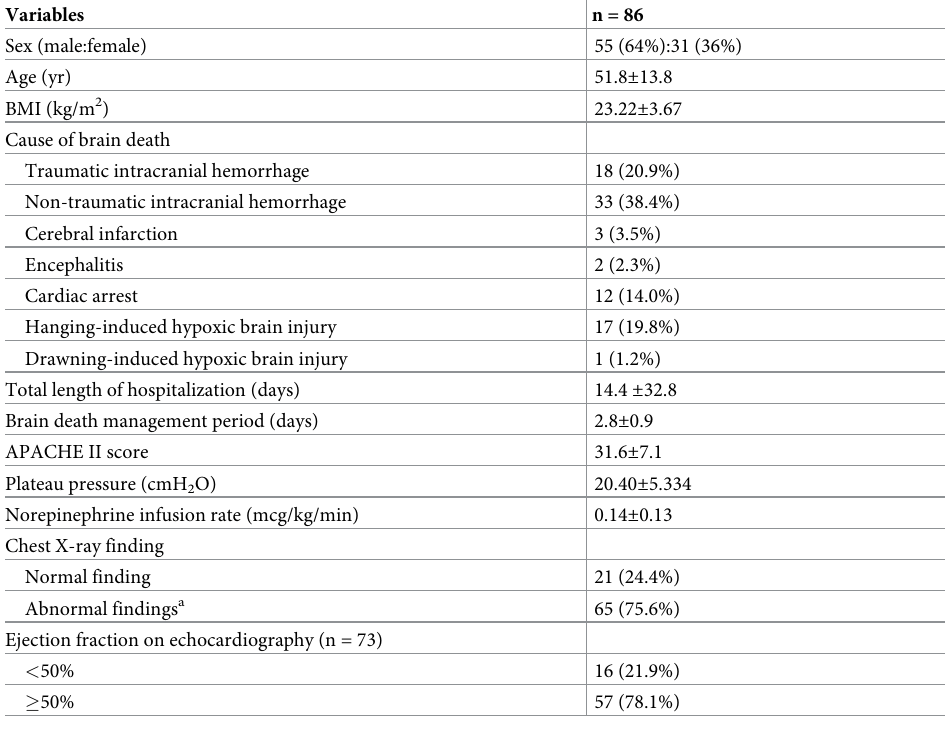
Table 1. Demographics and clinical